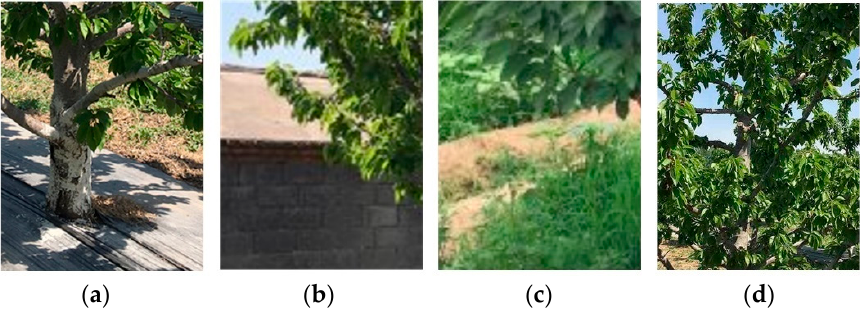
Figure 1. Challenges of crown segmentation in the unstructured environment: ( a ) sky, land and cover films; ( b ) house; ( c ) uneven light distribution within the canopy images; and ( d ) weeds.